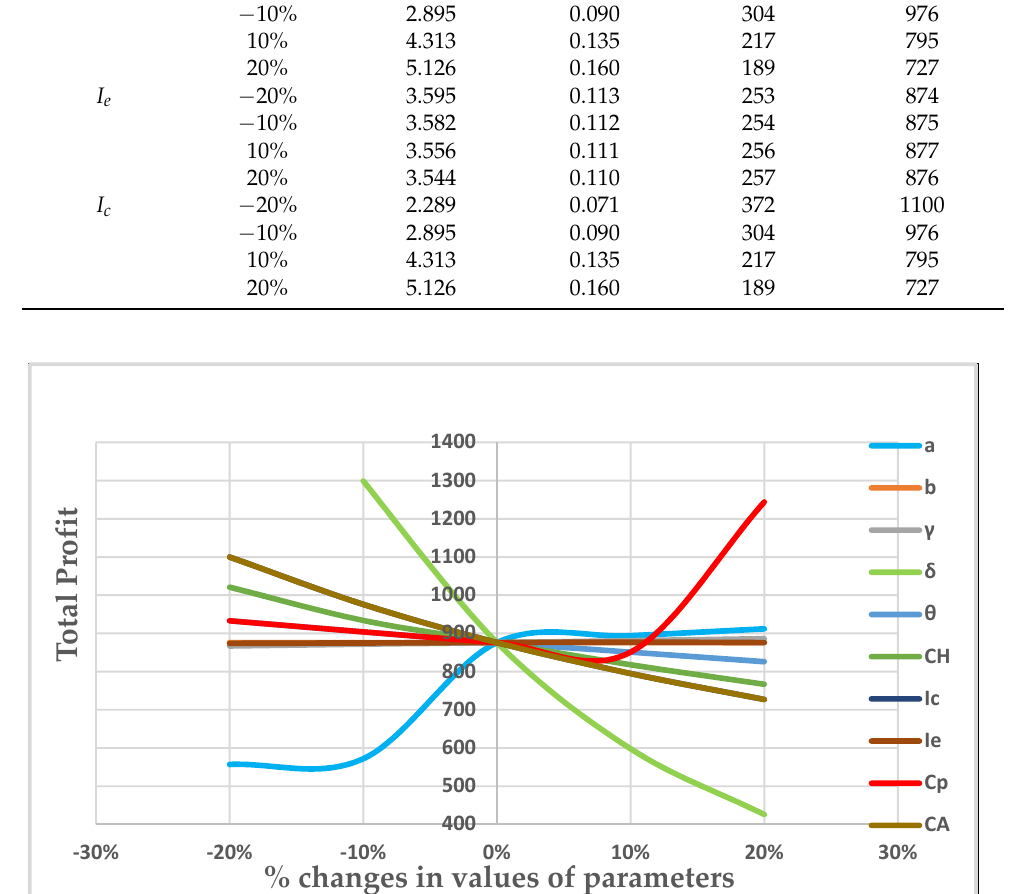
Figure 4. Sensitive analysis for different parameters.